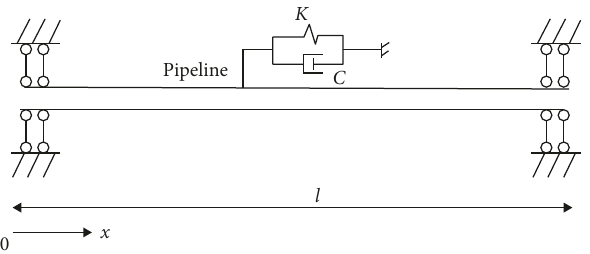
Figure 2: Pipeline longitudinal vibration calculation model and boundary conditions.